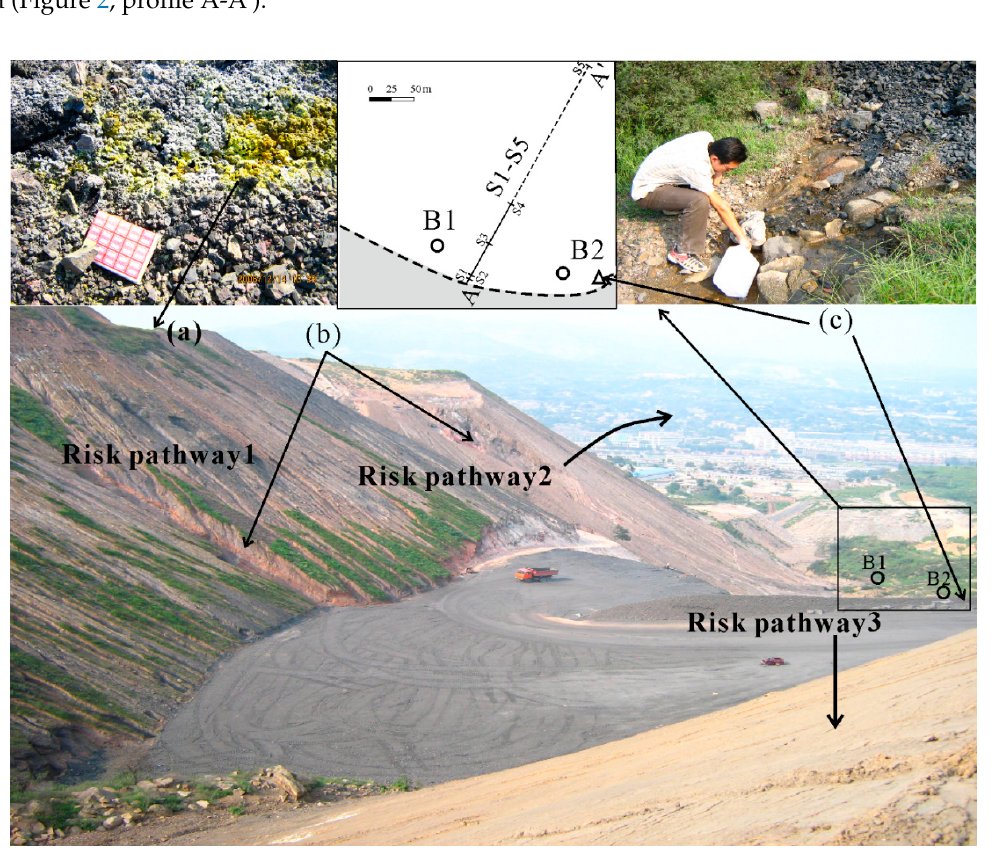
Figure 2. The largest coal spoil pile in Yangquan coal mine, No. 2 Coal Mine. ( a ) CSFGM, coal spoils fire gas minerals; ( b ) fired coal spoils; ( c ) leachate discharge from the coal spoil piles; S1–S5, soil samples collected in the front of the coal spoil bank with a distance of 5, 10, 50, 100, and 500 m (profile A–A’); B1 and B2, bore holes; bold dash line, the front boundary of the coal spoil bank. Also shown